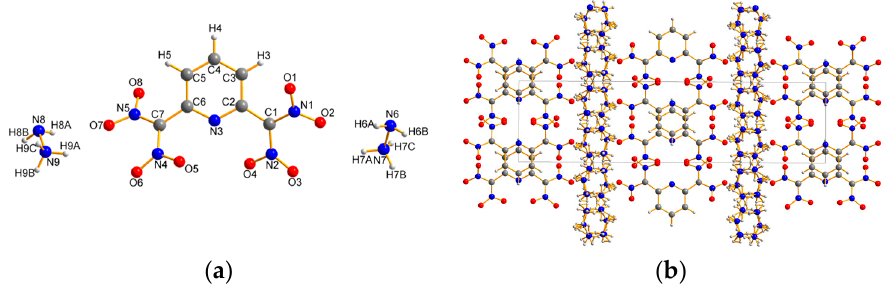
Figure 6. ( a ) Molecular structure of 5 . The disordered hydrazinium cations were partly deleted for clarity; ( b ) packing diagram of 5 viewed down the c-axis.